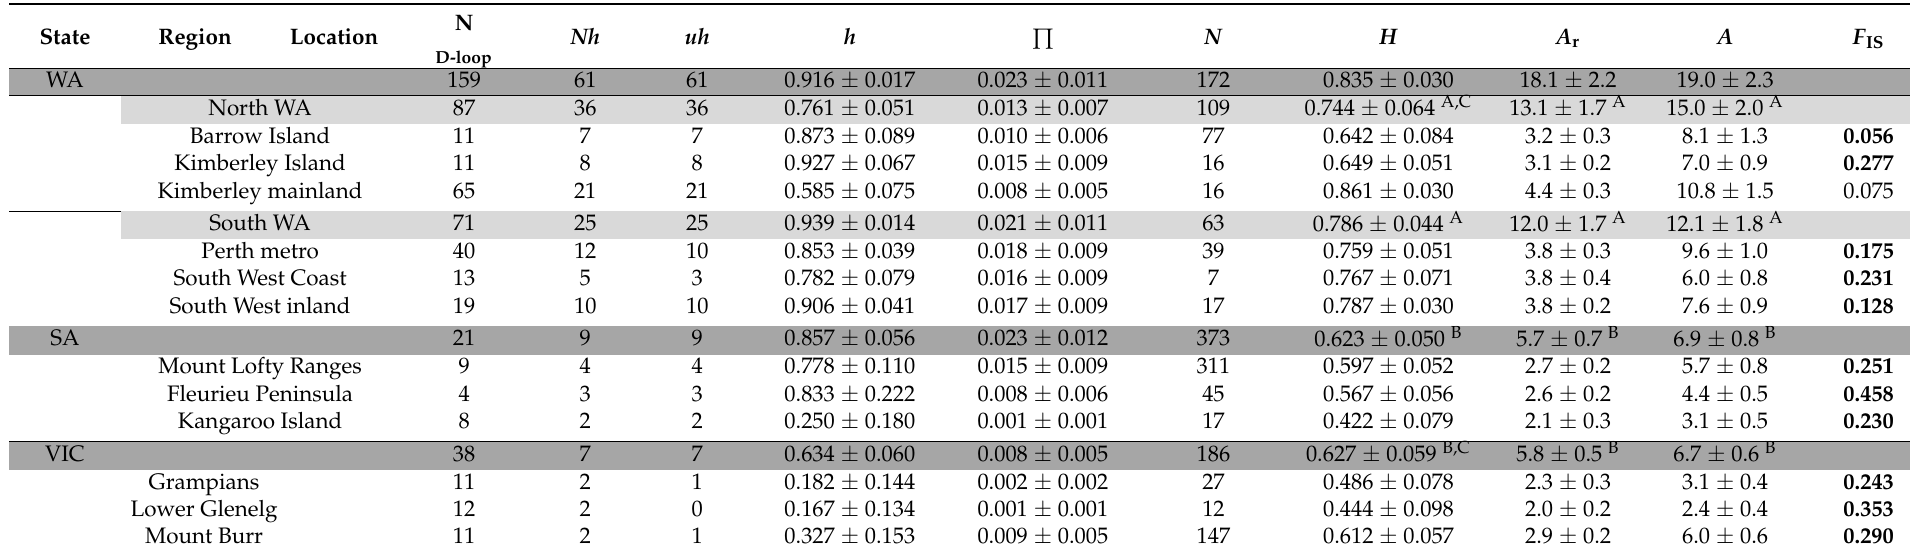
Table 3. Nuclear and mitochondrial DNA genetic diversity characteristics of Isoodon